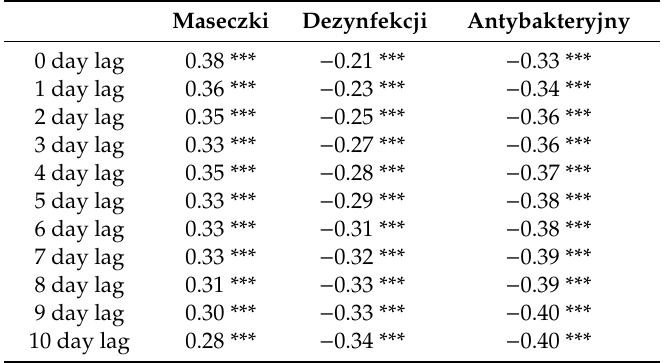
Table 4. Day Lag Correlations between New Cases and the keywords in Poland.